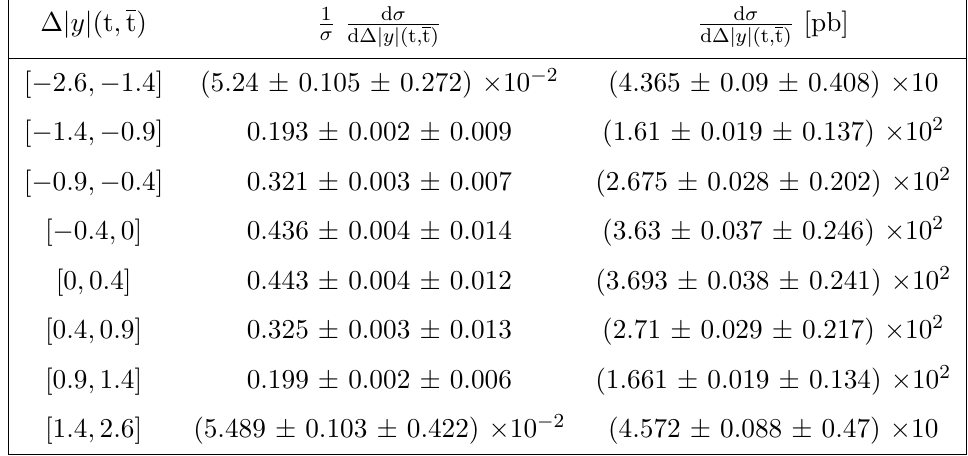
Table 13 . The measured di(cid:11)erential cross section and bin boundaries for each bin of the normalized and absolute measurements of the tt di(cid:11)erential cross section at parton level in the full phase space as a function of (cid:1) j y j (t ; t) are tabulated.